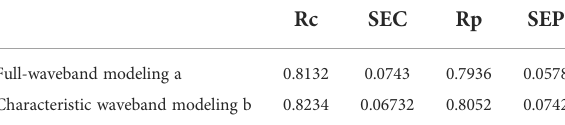
TABLE 3 Modeling results of full-wave band and characteristic waveband with optimal